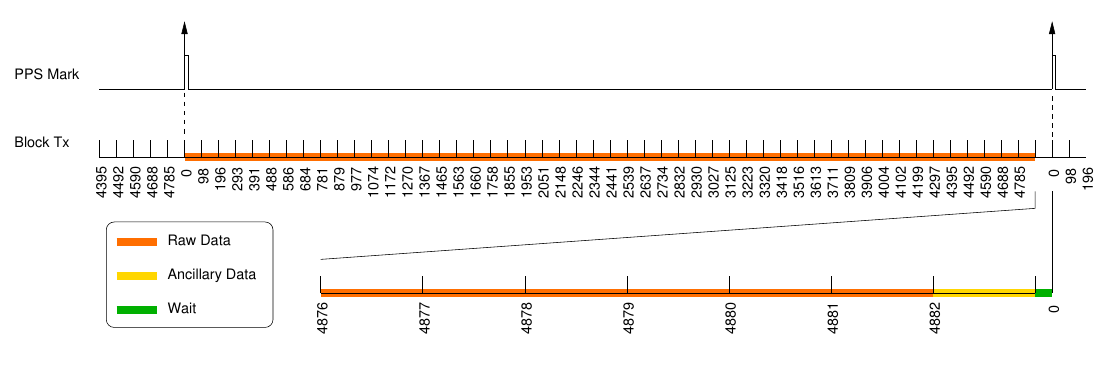
Figure 6. Data Recorder GPS one-second